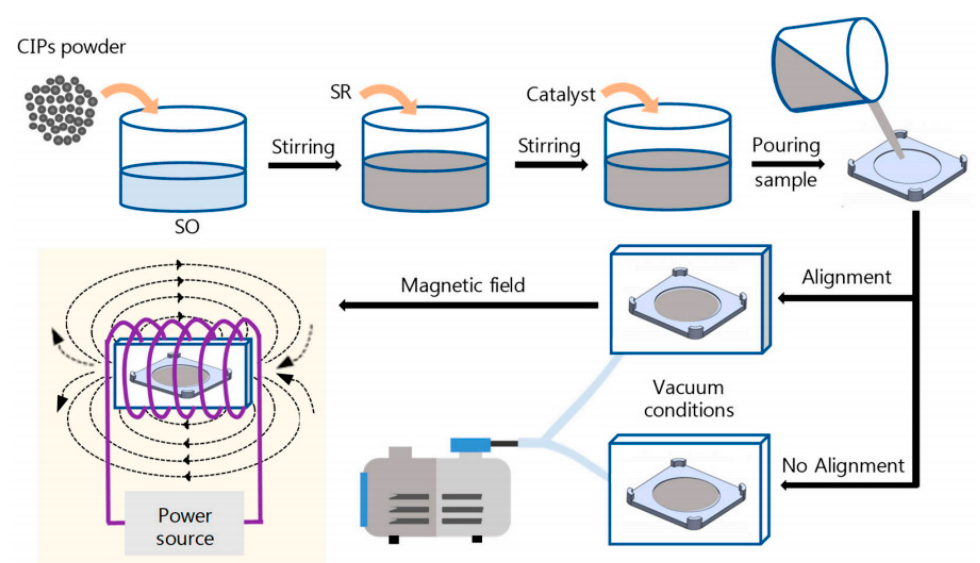
Figure 1. Schematics of manufacturing step of both isotropic and anisotropic magnetorheological elastomer (MREs) (stirring, mixing, and alignment with or without magnetic field) [48].